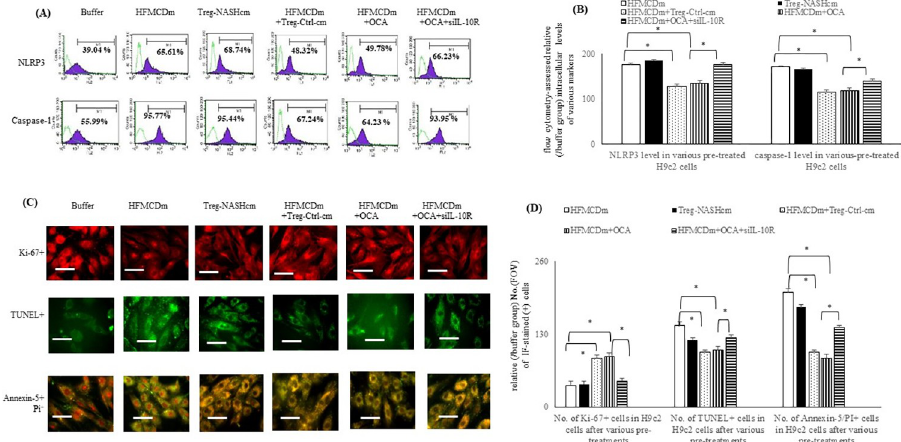
Fig 5. Treg-NASHcm and HFMCDm increased the inflammasome and inhibited the proliferative H9c2 cells. Flow cytometry-assessed relative intracellular levels (/buffer group) of ( A ) FXR, IL-10R, IL-10, ( B ) NLRP3, caspase-1 among various CM pre-treated H9c2. Bar graph of ( C ) immunofluorescence-assessed Ki-67 + cells (red color), TUNEL + cells (green color), and ( D ) Annexin-5 + PI + (orange color) cells in all H9c2 cells. Scale bars in all images are 100 mm; CD4 + CD25 + Treg-NASH+OCA [supernatant of Treg cells from NASH mice as condition medium (cm) plus acute OCA incubation]; field of view (FOV).